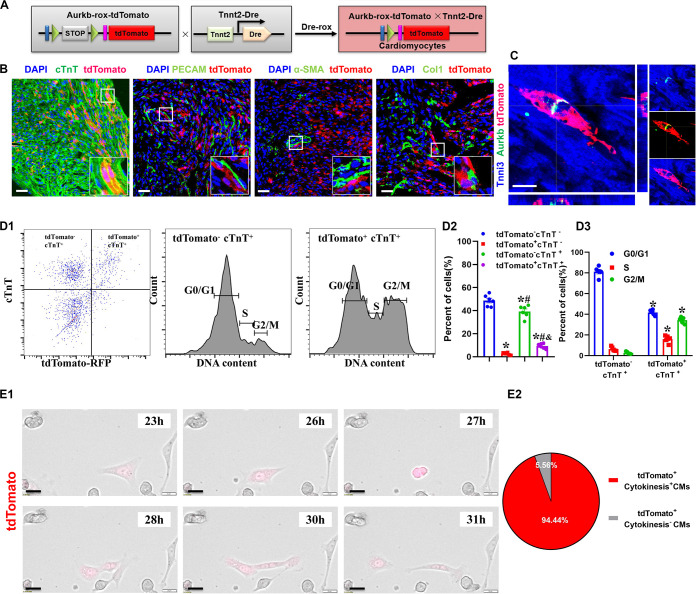
The proliferating ventricular cardiomyocytes were efficiently labeled in Tnnt2-Dre × Aurkb-rox-tdTomato neonates. (A)
Tnnt2-Dre mice were used to cross with Aurkb-rox-tdTomato mice to label proliferating cardiomyocytes. (B) Immunostaining showed the coexpression of tdTomato with cTnT, PECAM, à-SMA, or Col1 on P1 Tnnt2-Dre × Aurkb-rox-tdTomato heart sections. Scale bar = 40 μm. (C) Immunostaining for tdTomato with Aurkb on P56 Tnnt2-Dre × Aurkb-rox-tdTomato heart sections. Scale bar = 20 μm. (D) Representative images of flow cytometry analysis (D1) and quantification of tdTomato± cells (D2) and numbers in G1, S, G2/M phases (D3) from ventricles of P1 Tnnt2-Dre × Aurkb-rox-tdTomato mice. (D2)
n = 6, *p < 0.05 vs. tdTomato–cTnT–; #p < 0.05 vs. tdTomato+cTnT–; &p < 0.05 vs. tdTomato–cTnT+. (D3)
n = 5, *p < 0.05 vs. tdTomato–cTnT+. (E) Representative images (E1) and quantification (E2) of time-lapse imaging analysis showed cell proliferation in vitro of tdTomato+ cardiomyocytes from the ventricles of P1 Tnnt2-Dre × Aurkb-rox-tdTomato mice. Scale bar = 20 μm.